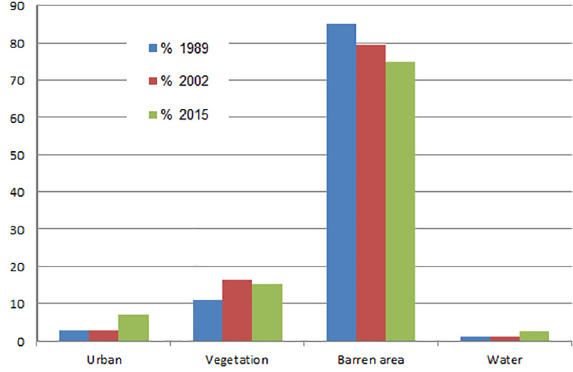
Figure 5. Classified map of LULC, 2015